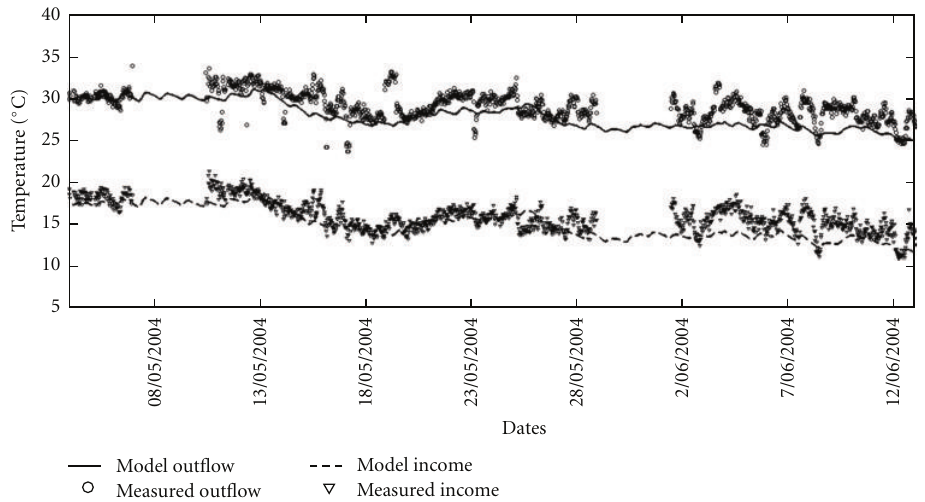
Figure 11: Comparison of the measured and modeled temperaturesin the income and outflow of the power plant with the 5th and 6th units in operation for the days between 3 May and 15 June